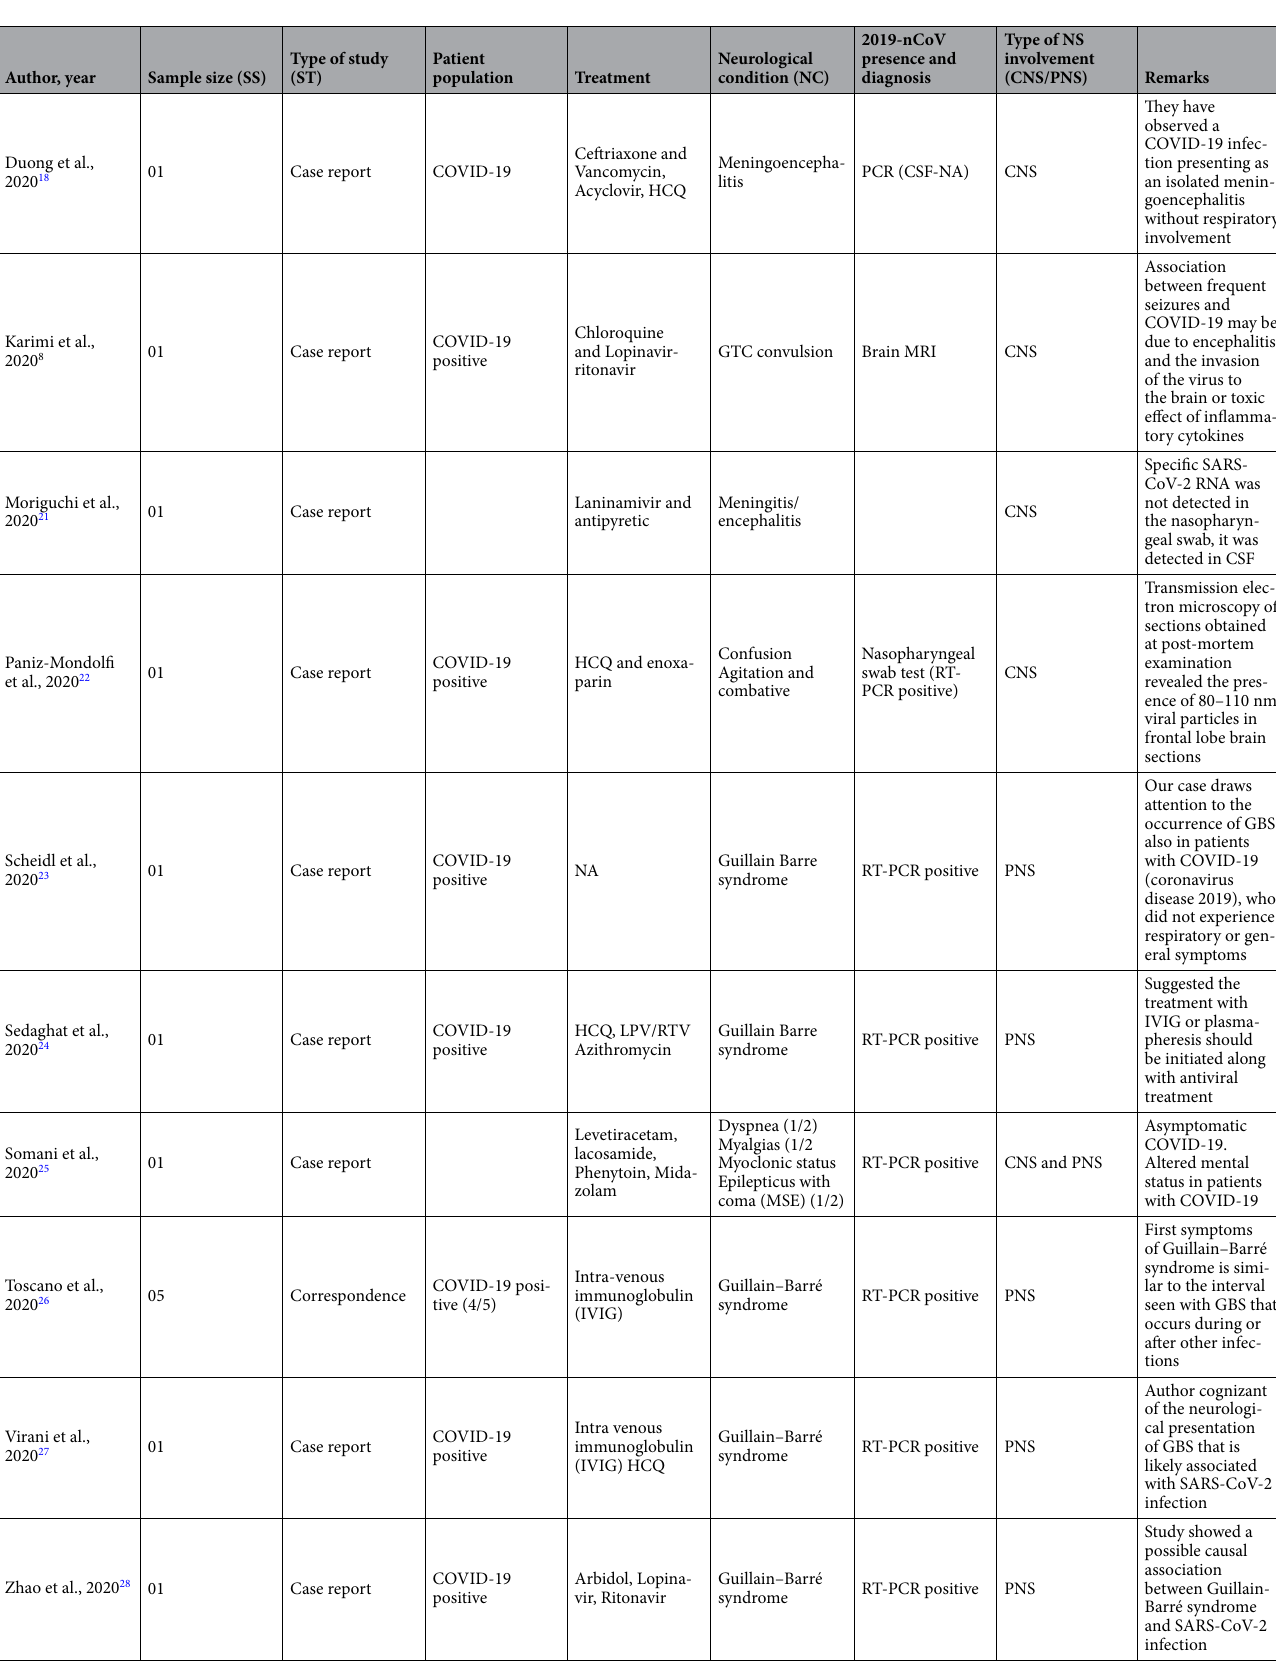
Table 2. Published case reports of neurological manifestations in COVID-19 positive patients. NS nervous system, HCQ hydroxy chloroquine, HCQ hydroxy-chloroquine, LPV/RTV lopinavir/ritonavir, GBS Guillain– Barré